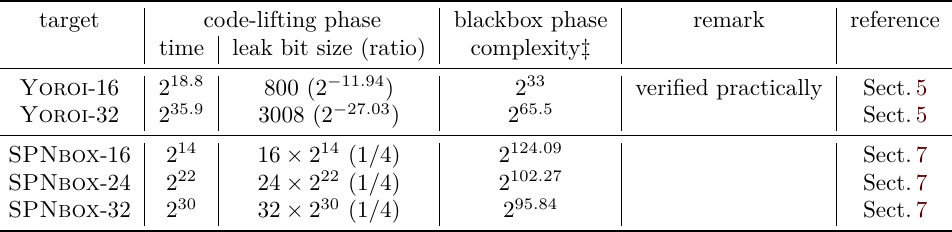
Table 1: Summary of hybrid code lifting on Yoroi and SPNbox .